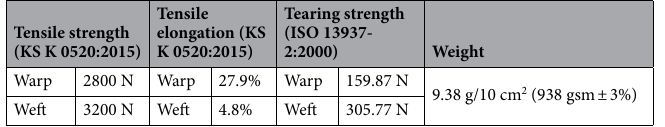
Table 3. Features of para-aramid shielding fabric with tungsten coating.